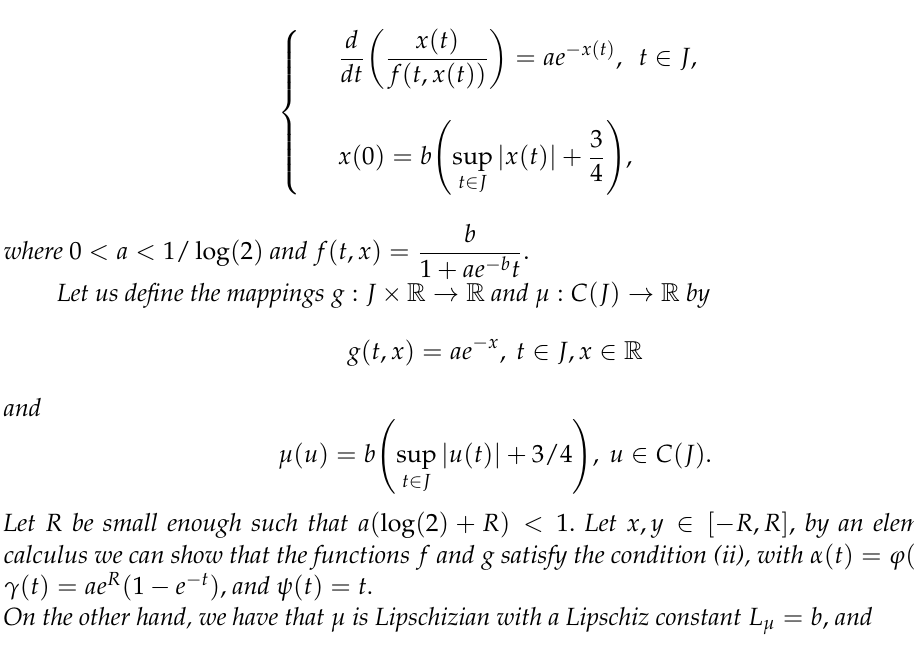
Table 1. Numerical results for (12) with initial x 0 ( t ) = 1